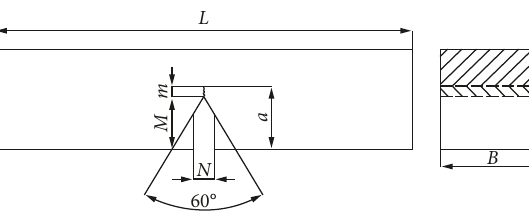
Figure 2: Three-point bending specimen SE(B).